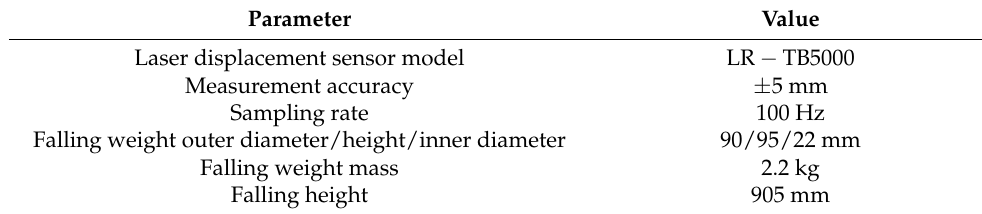
Table 3. Parameter values of the actual experiment.